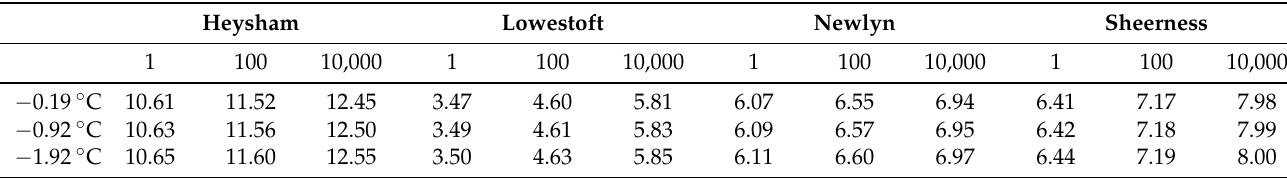
Table 4. Estimates of the 1100 and 10,000 year sea level return levels (in metres), relative to the mean sea level in 2017, using Models R 4 and S 0 for the GPD rate and scale parameters, respectively, for skew surges with GMT as a fixed covariate equal to anomalies of − 0.19 ◦ C (as in 1915), 0.92 ◦ C (as in 2020) and 1.92 ◦